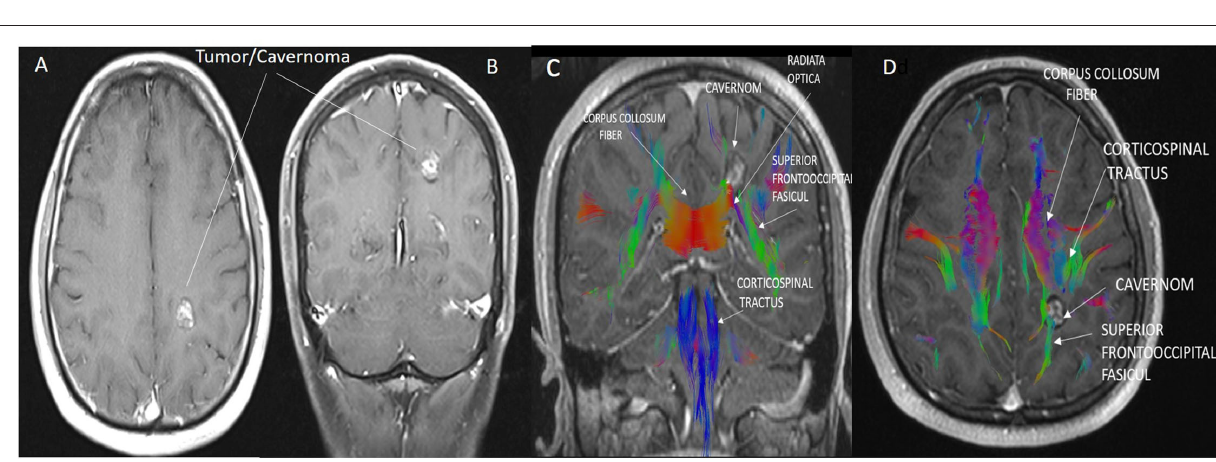
Frontiers in Surgery |